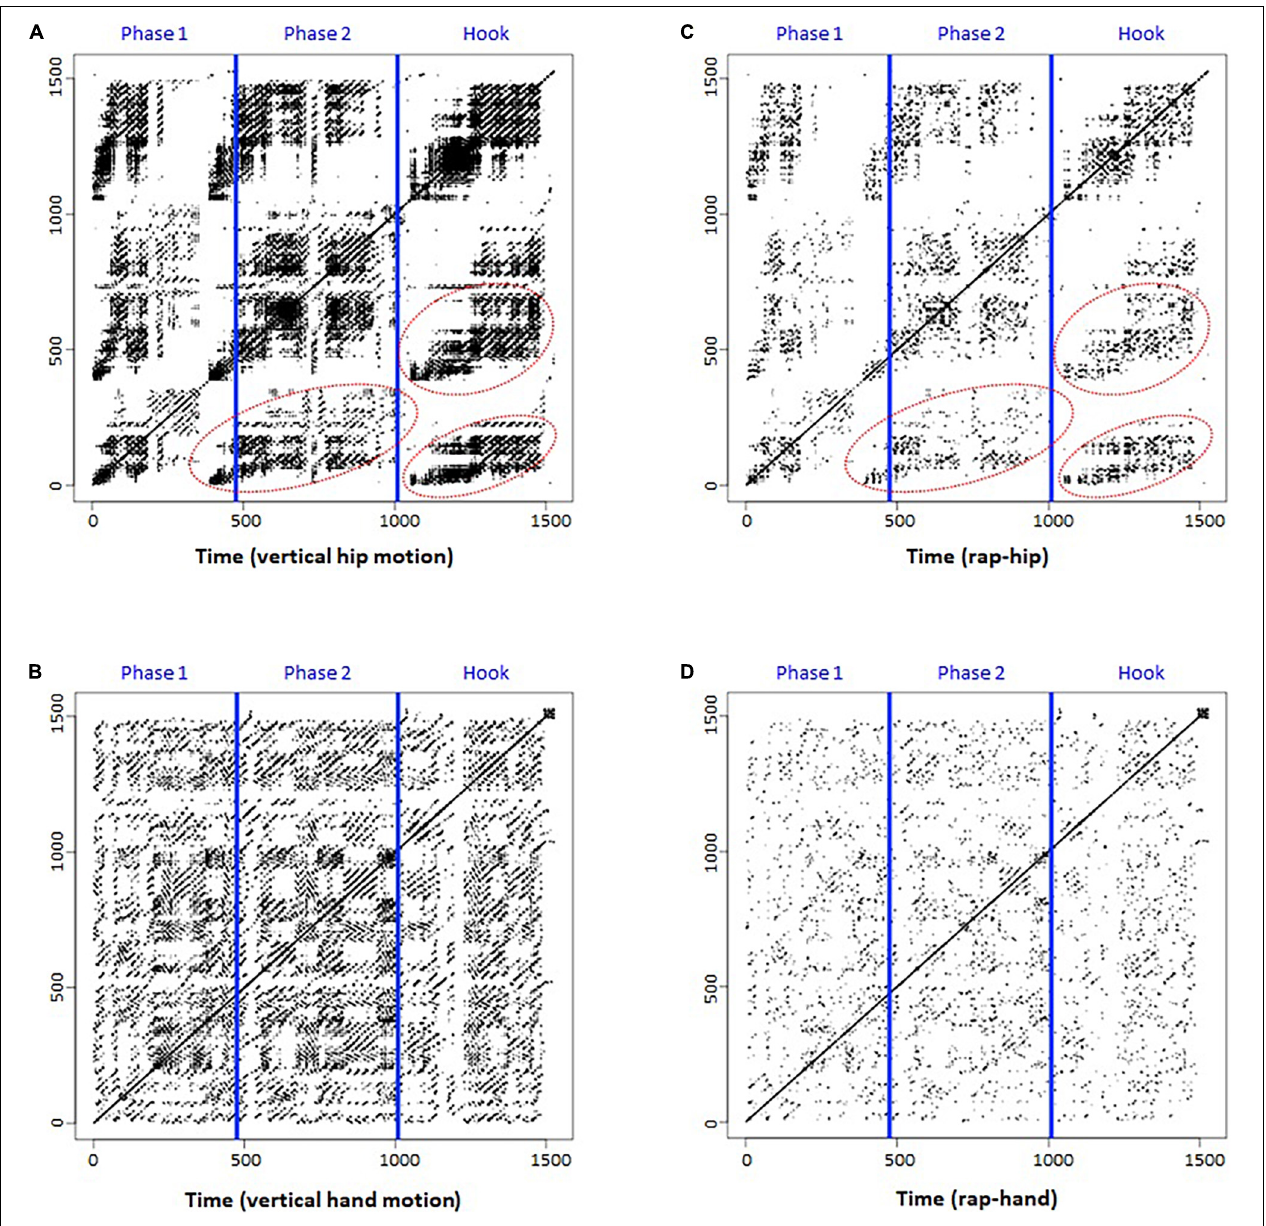
FIGURE 3 | Continuous recurrence plot (CoRP) of rap and Joint recurrence plot (JRP). (A) CoRP of hip. (B) CoRP of hand. (C) JRP of rap-hip. (D) JRP of rap-hand. Both x - and y -axes represent time